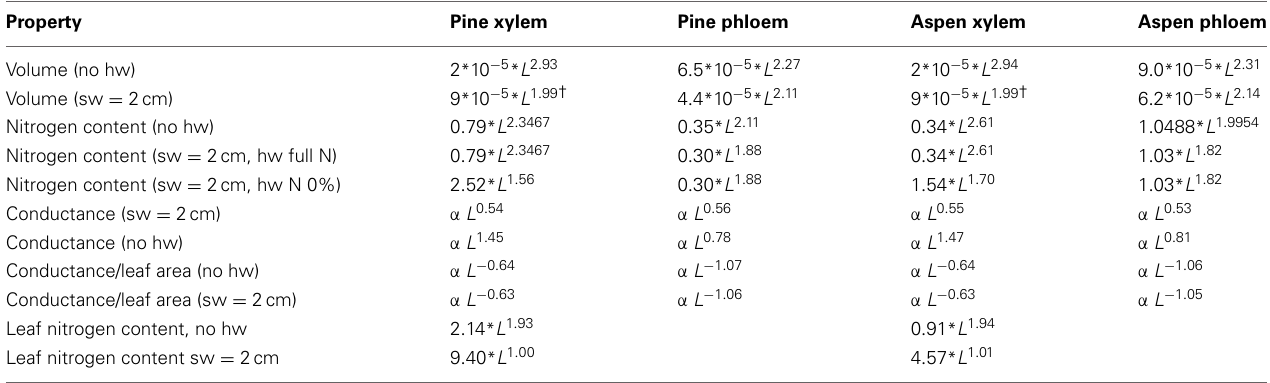
Table 4 | The results for scaling of tree properties as a function of tree height ( L ).